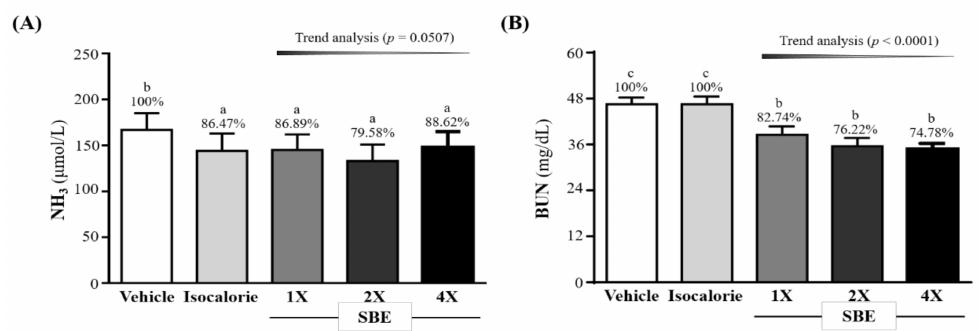
Figure 2. Effect of supplementation with SBE on serum ( A ) NH 3 and ( B ) BUN. Data are expressed as mean ± SD for n = 10 mice per group. The different superscript letters (a, b, c) above each bar indicate a significant difference at p < 0.05. NH 3 : blood ammonia; BUN: blood urea